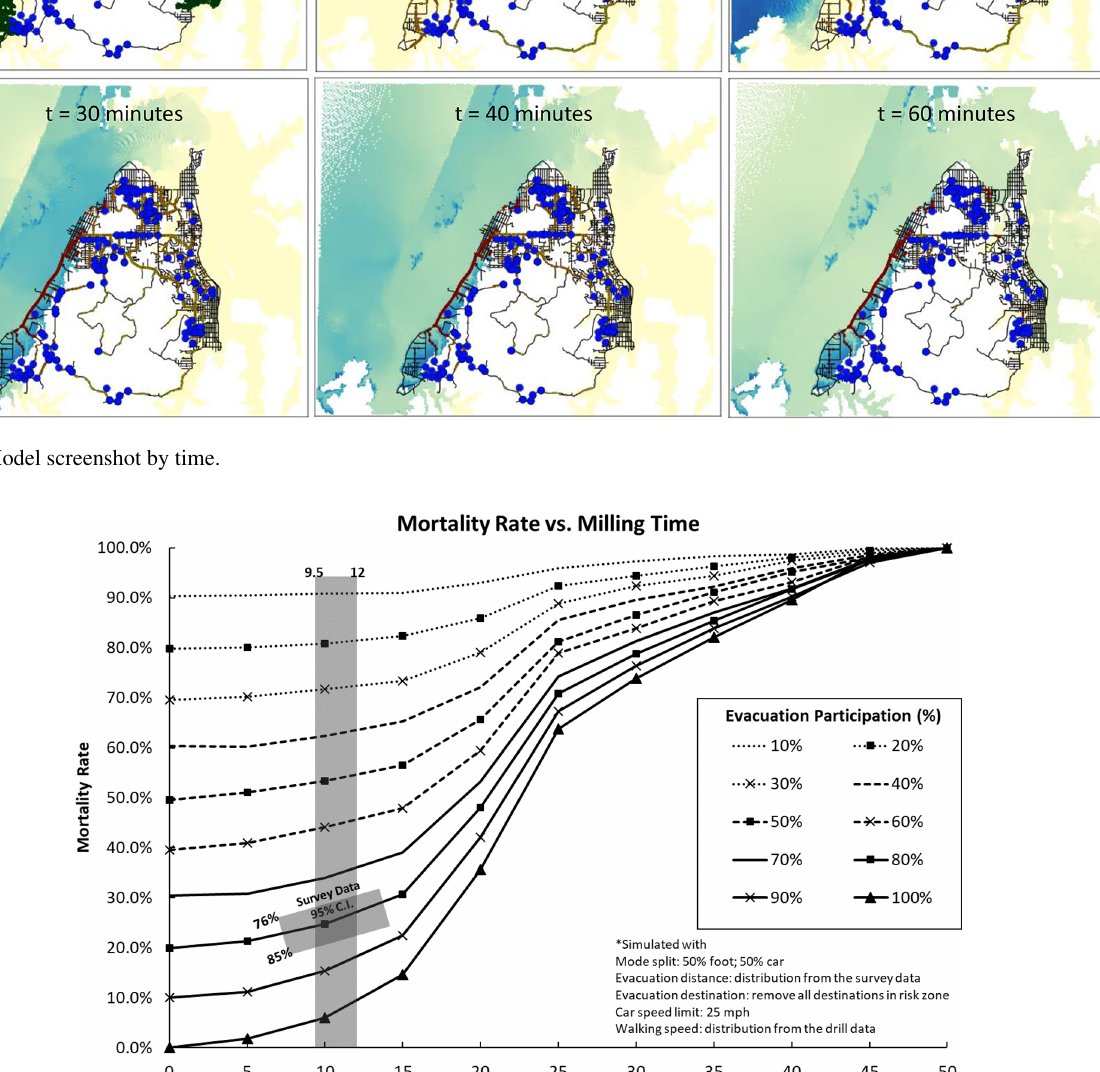
Figure 6. Estimated mortality rate of the inundation zone population as a function of milling time and evacuation